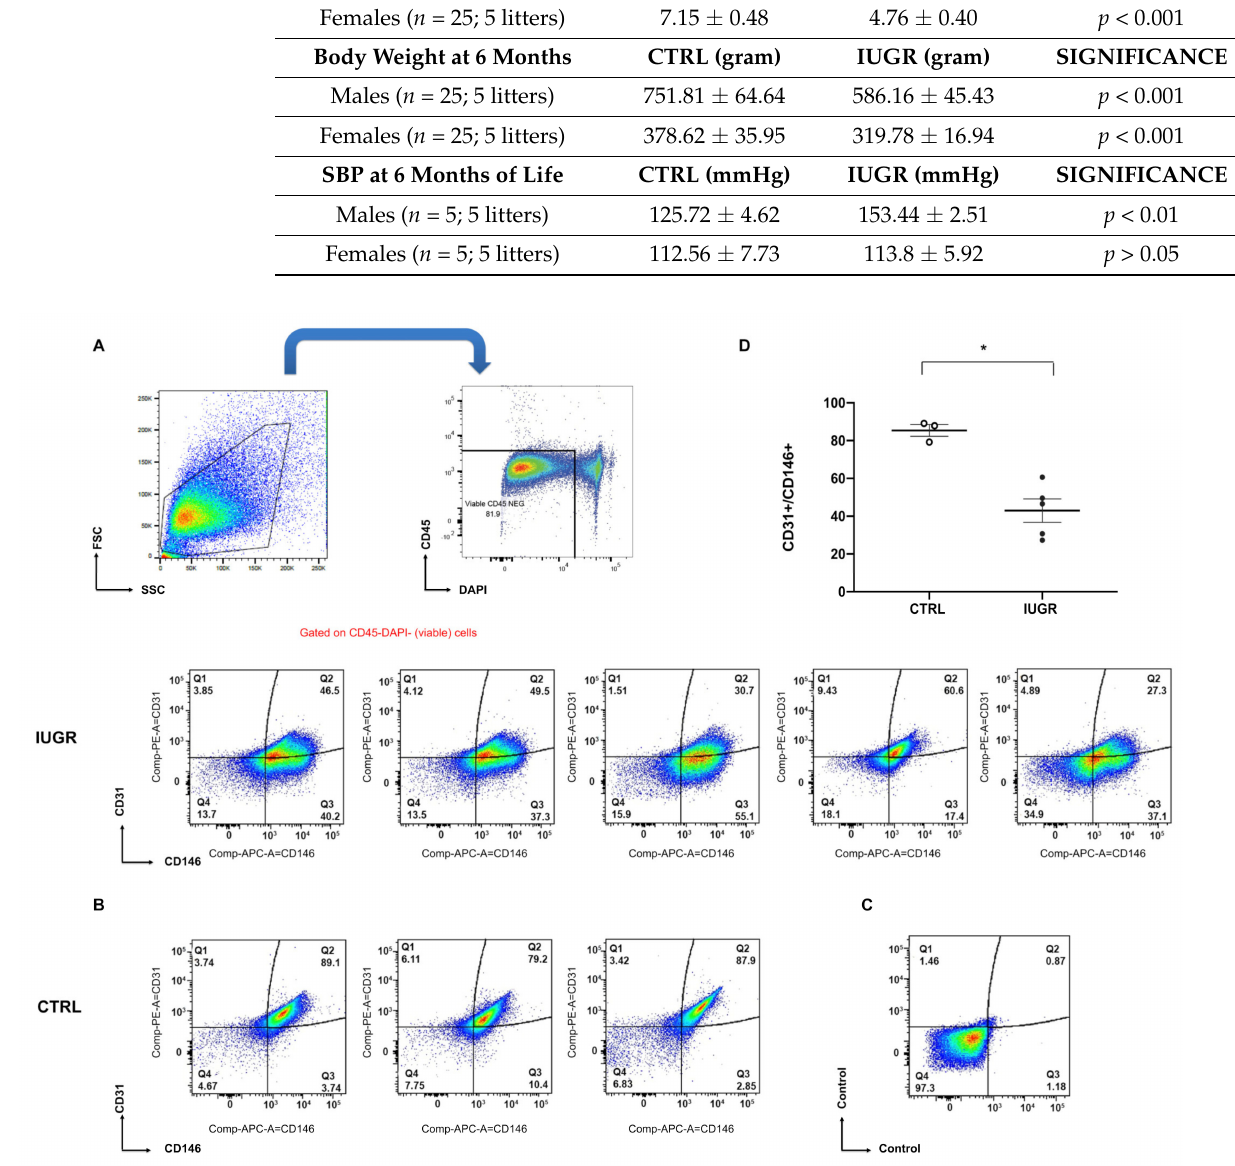
Figure 2. ECFC quantification. Flow cytometry analysis of cultured cells was performed on CTRL-ECFCs and IUGR-ECFCs isolated from six-month-old male rats. ( A – D ). Left panel; FSC versus SSC plot. Cells were gated to exclude subcellular debris. Right panel; CD45 versus DAPI staining on gated cells from left panel ( A ). Dead cells (DAPI+) and hematopoietic cells (CD45+) were excluded by gating CD31+ versus CD146+ staining on CD45-viable cells ( B ). Upper panel, cells from IUGR rats, lower-left three panels from CTRL rats, and values were reported in the histogram ( D ). Negative control stain on CD45-viable cells (in the absence of CD31 and CD146) was represented in the lower-right panel ( C ); * p <